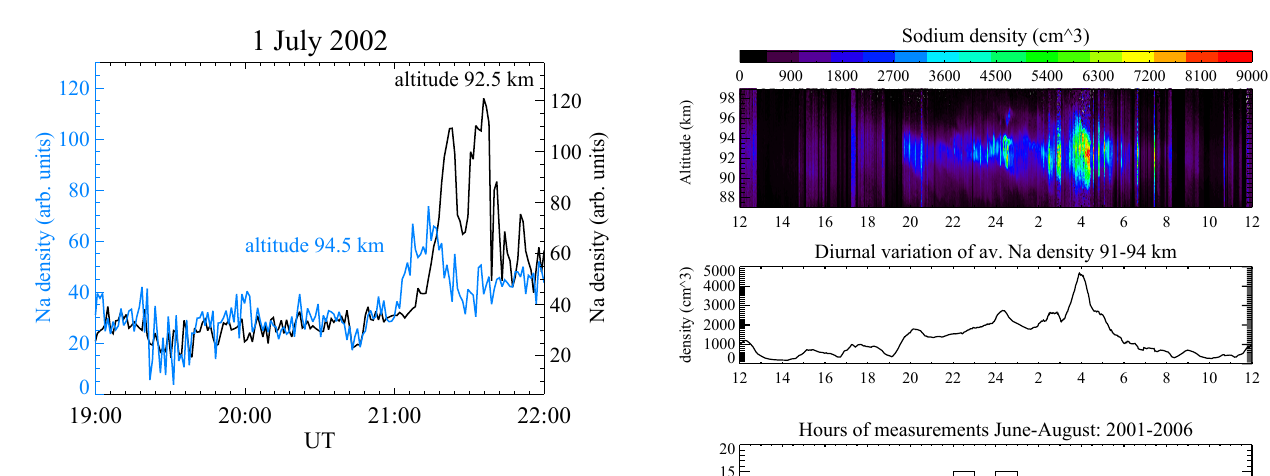
Fig. 7. The plot shows the sudden Na density enhancement at 1 July 2002. We observed a strong, short-lifetime enhancement ten minutes before the observed long-duration sudden enhancement at a 2km higher altitude.